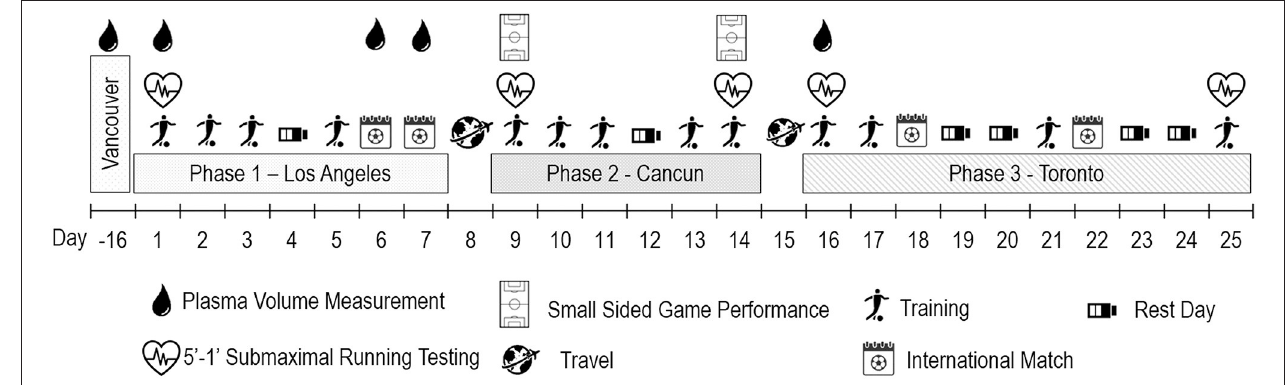
FIGURE 1 | Overview of the study design. Between day − 16 and the start of the study, players return home in different places in Canada for a regeneration phase and remote